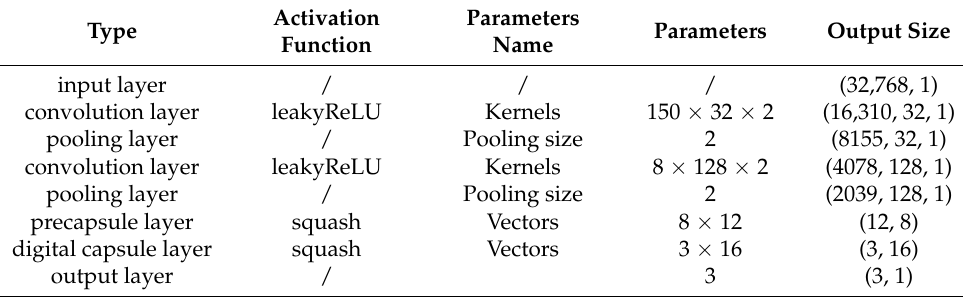
Table 2. ECCN Model structure parameters.